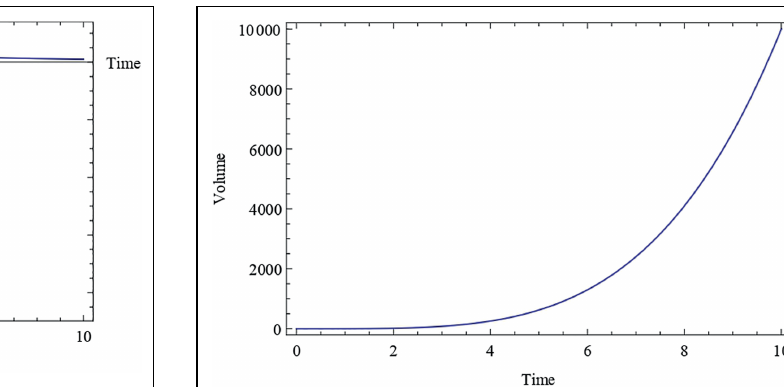
FIGURE 5 | Tension Density λ vs. time.